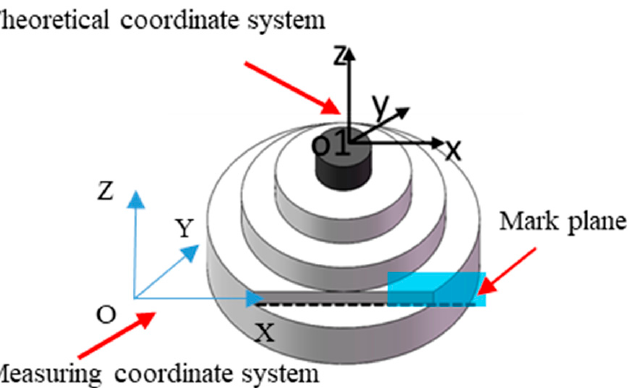
Figure 1. Schematic diagram of matching surface between measured and designed. The first step is to apply the fixture for rough positioning. As showed in Figure 2, there is a plane as the mark which is parallel to the plane comprised by axis X, axis Z, and measuring and theoretical coordinate systems are all based on the mark. Thus, the theoretical coordinate system and measuring coordinate system are quite alike.